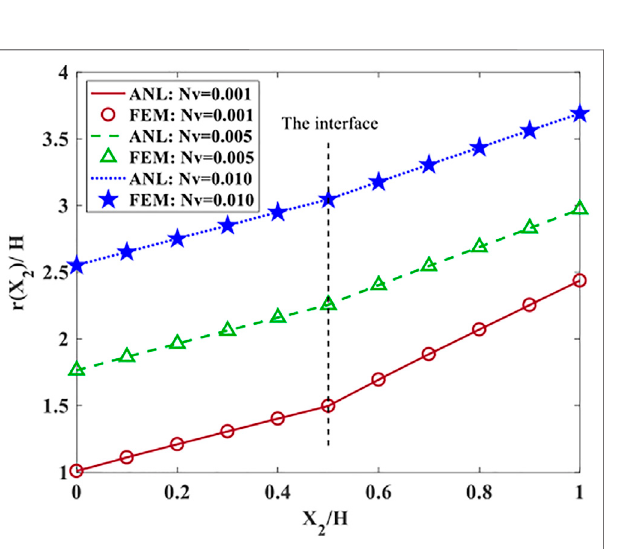
Frontiers in Materials |